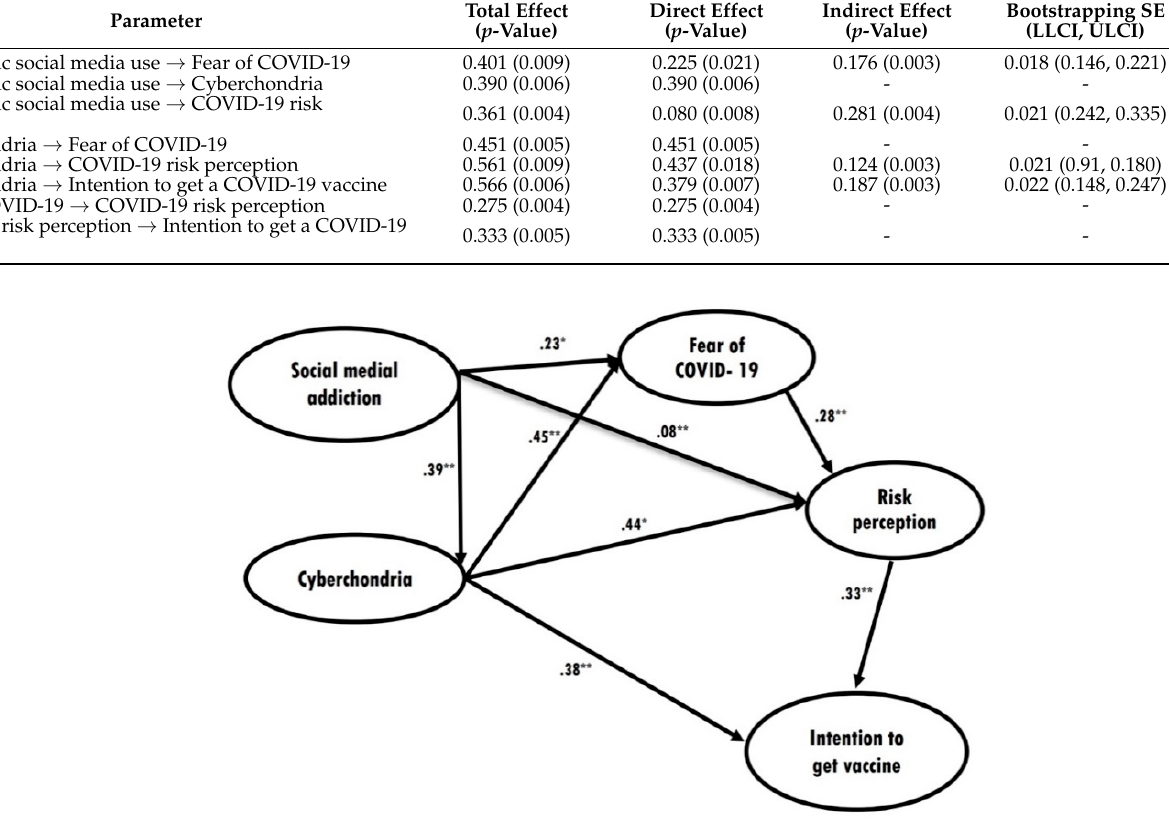
Table 4. Results of logistic regression model in explaining intention to get a COVID-19 vaccine.